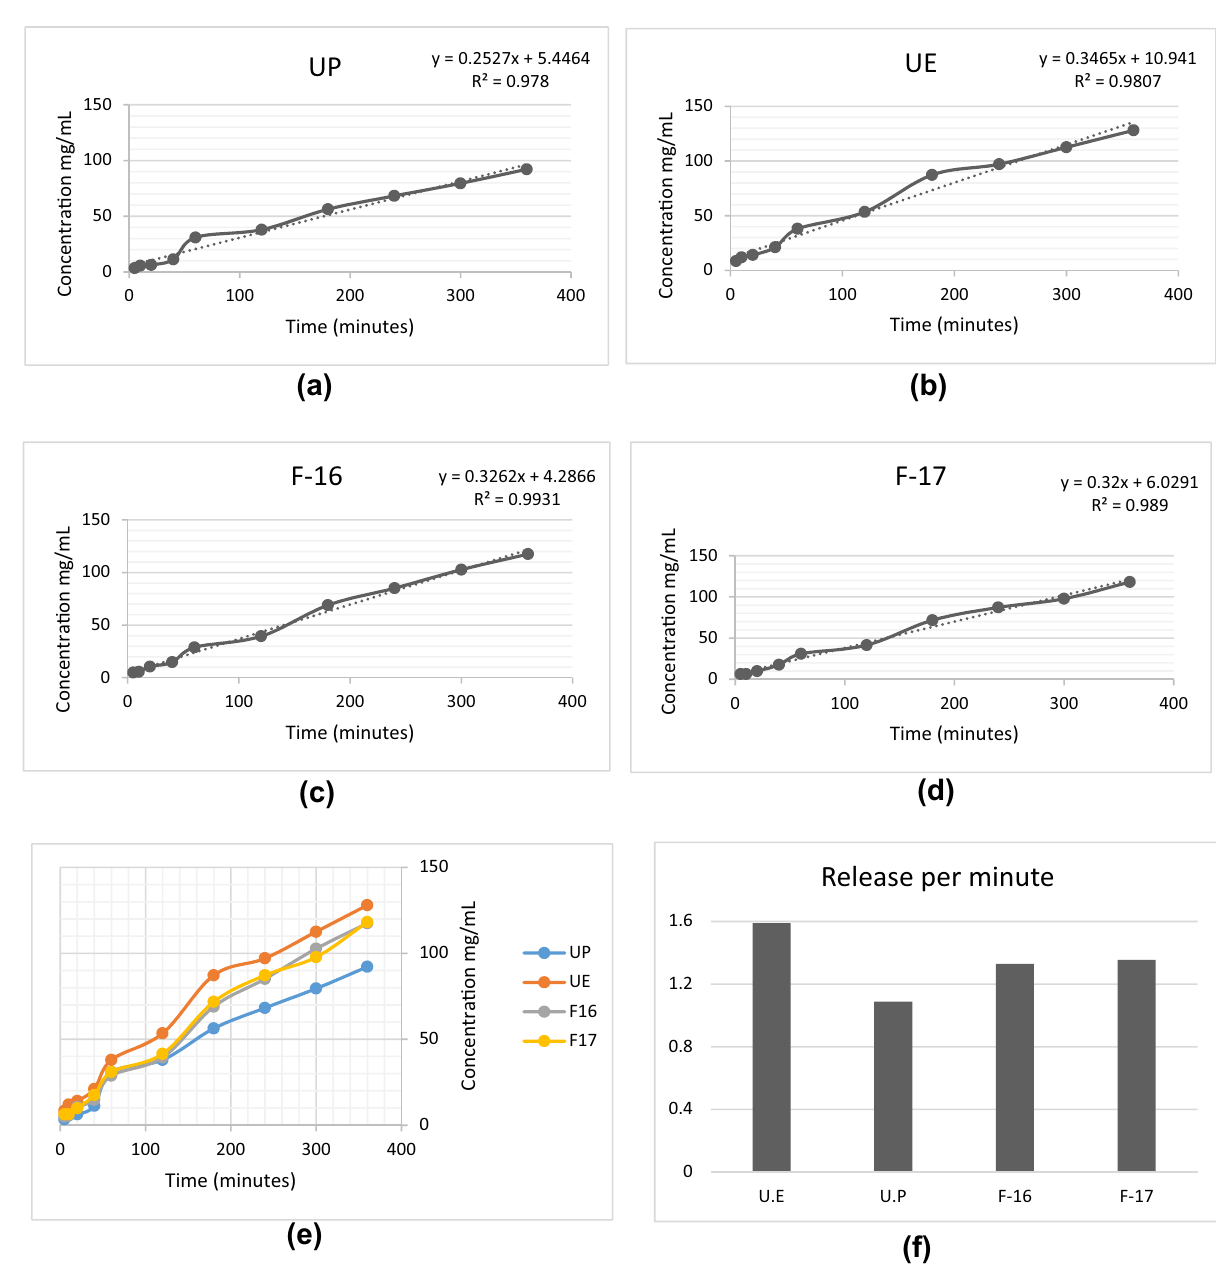
Figure 3. Solubilization test of UP ( a ), UE ( b ), F16 ( c ), F17 ( d ) all tested products ( e ) and Solubilization per minute of all products tested ( f